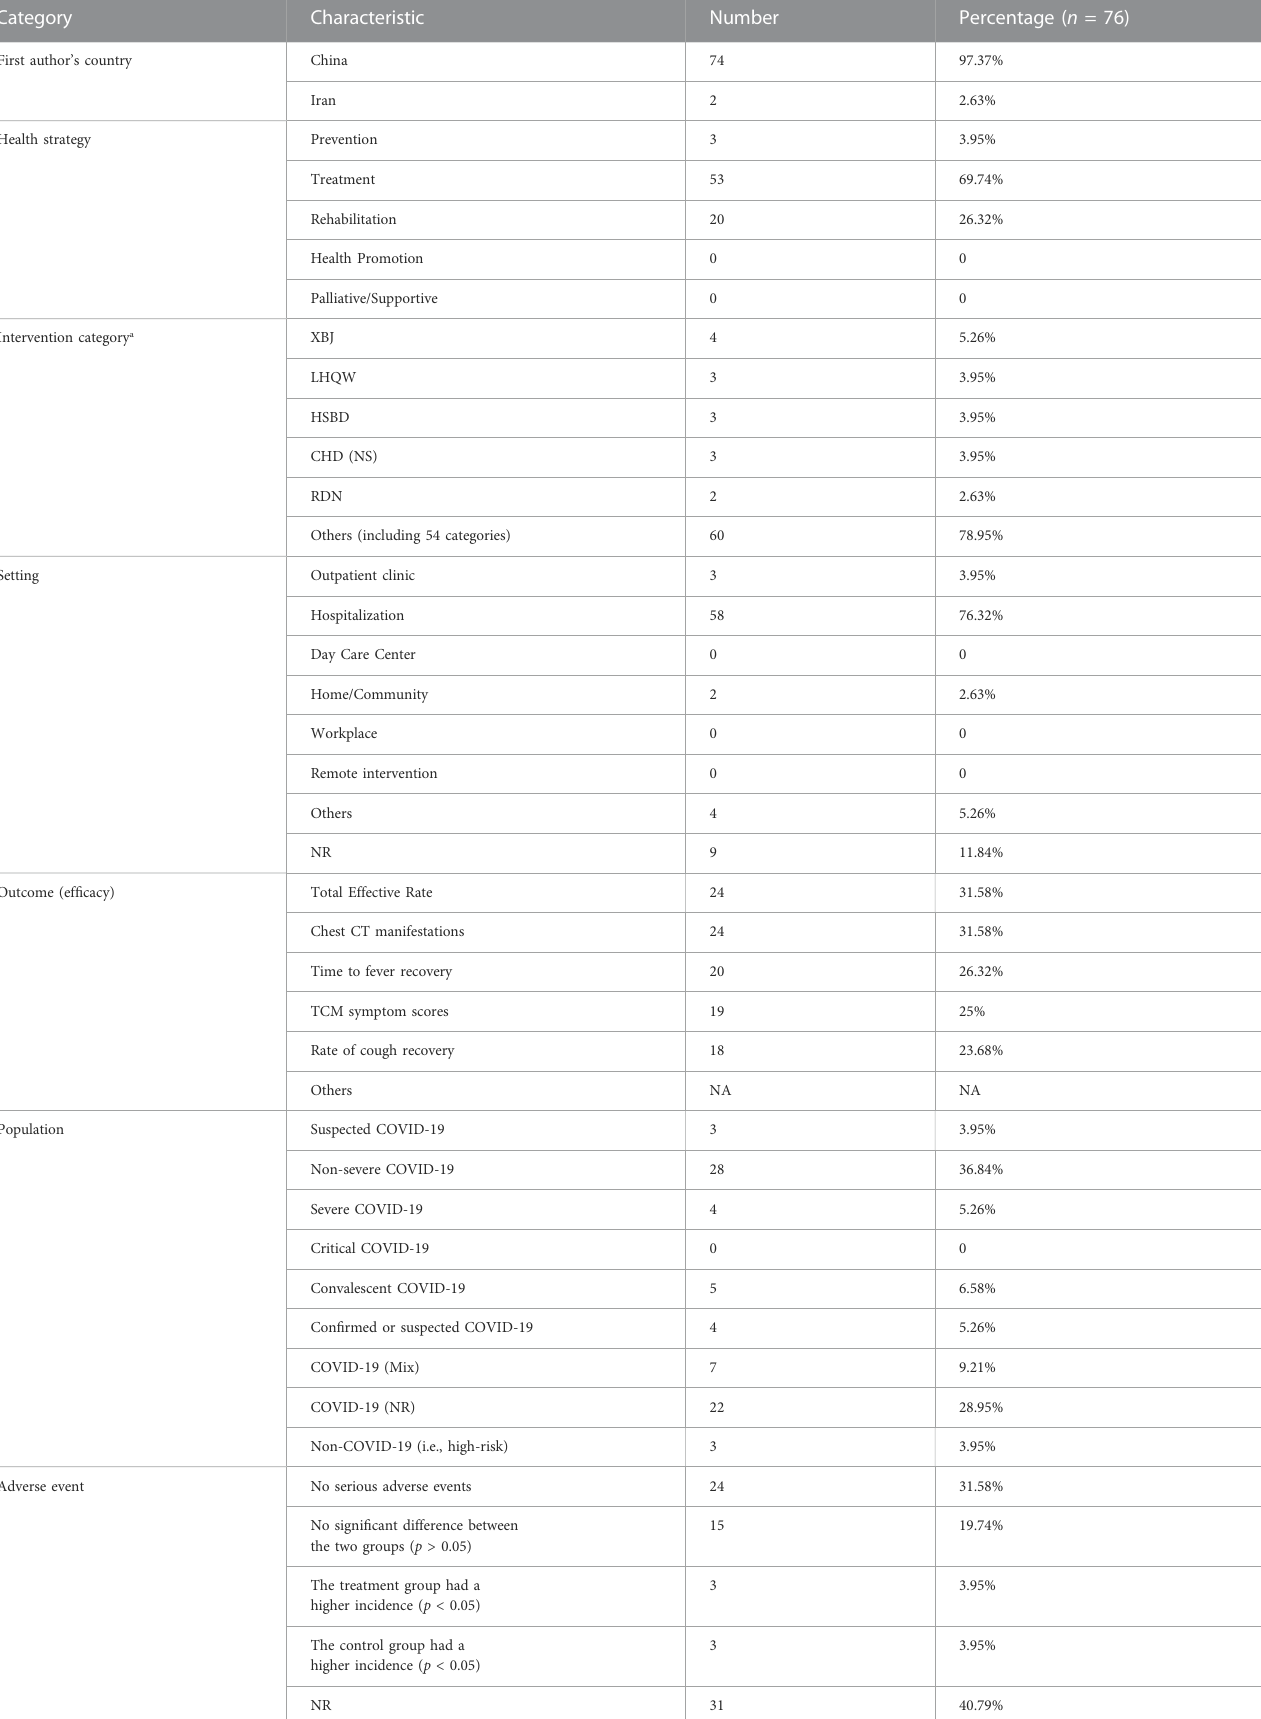
TABLE 1 Essential characteristics of the included